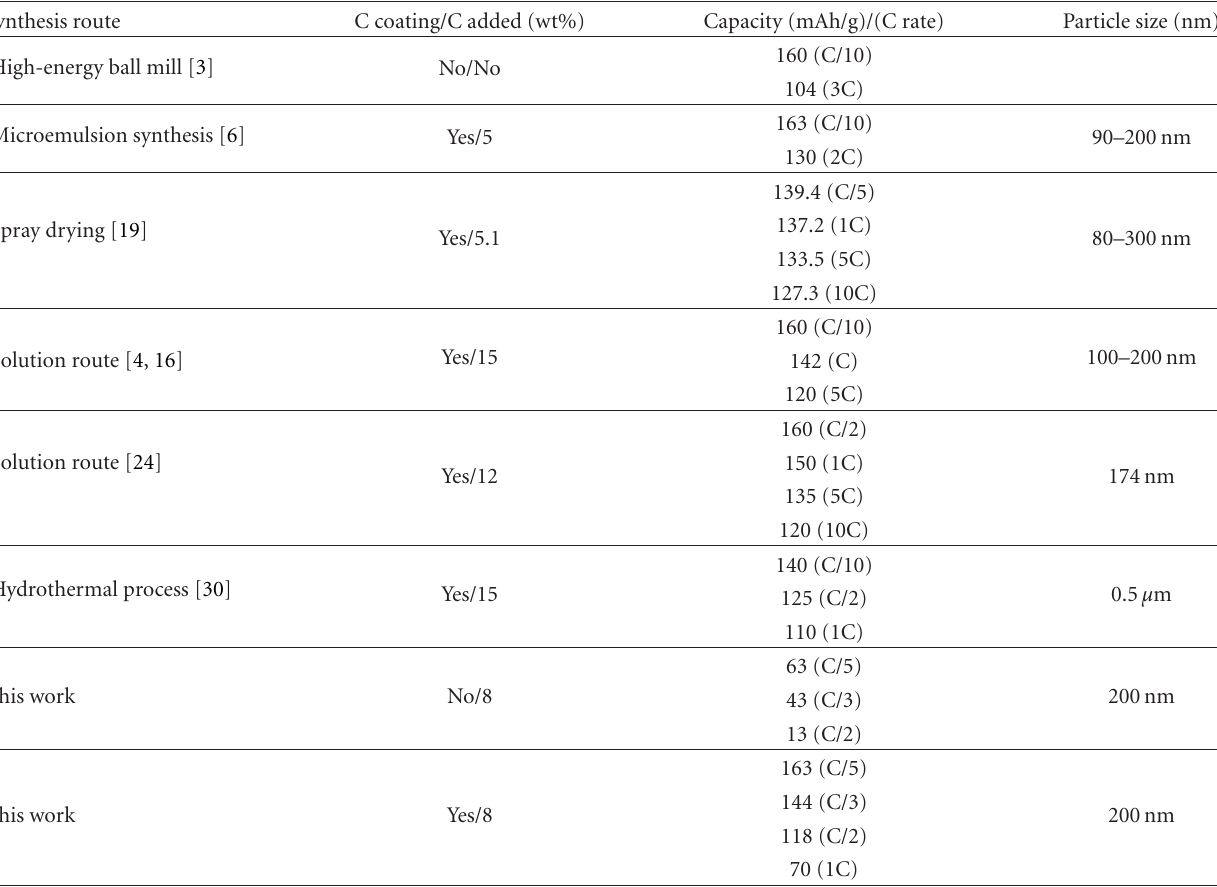
Table 1: Electrochemical properties of lithium iron phosphate